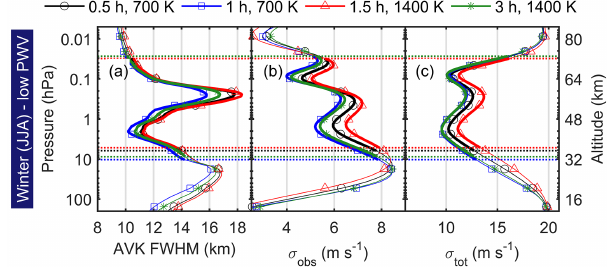
Figure 12. As Fig. 11, but simulated for different total measure- ment times and radiometer system temperatures and under optimal wintertime observing conditions at Halley where precipitable water vapour (PWV) is in the lower quartile (below 0.92mm).